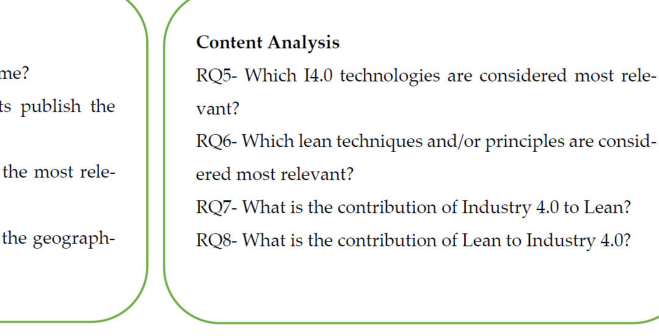
Figure 1. Specific research